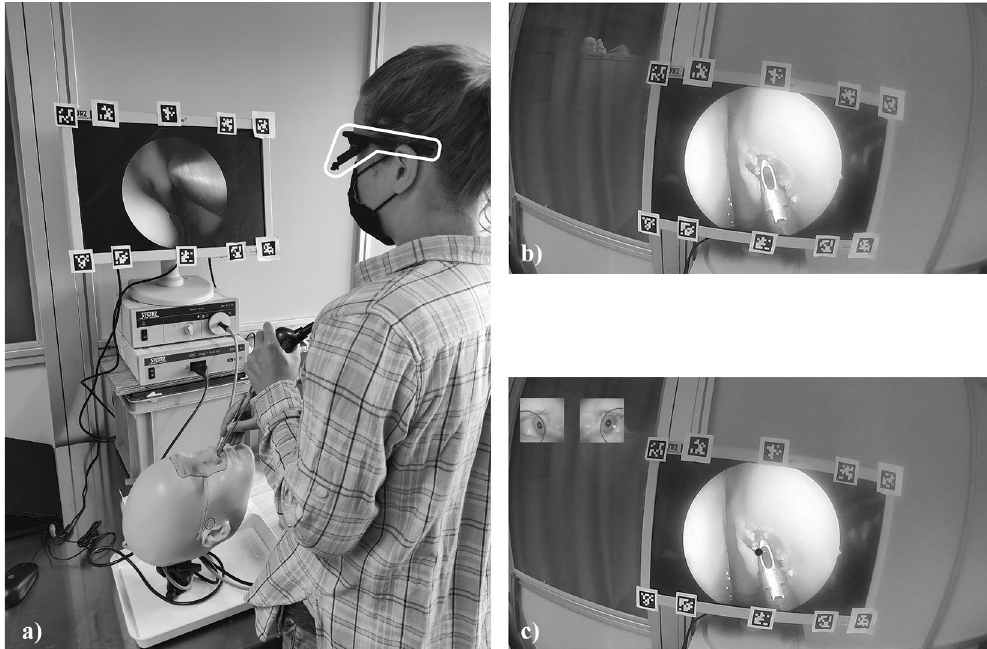
Figure 1. Study setup and instruction videos. ( a ) Participant performing endoscopic surgery. Eye movements are tracked with head mounted glasses, highlighted by a white frame. Black-white markers on the screen are used for the analysis of areas of interest. ( b ) Screenshot of the teaching video without gaze and ( c ) with gaze